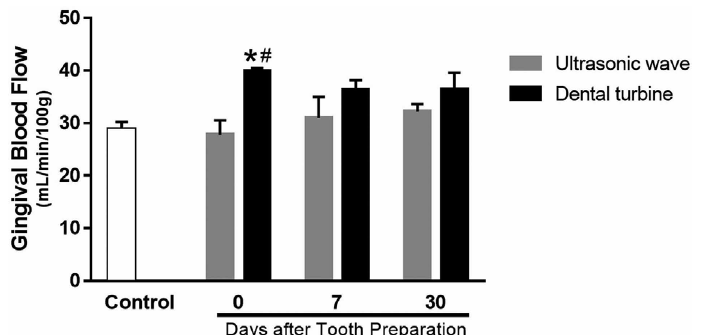
Figure 5- The effects of tooth preparation using ultrasonic or turbine on blood flow. The x axis represents the days after tooth preparation (ultrasonic: shaded column, turbine: closed column) and the y axis the gingival blood flow. Gingival blood flow was simultaneously determined at two points (mesial and centre) on each of the four lower premolar teeth and at the same site as the tooth preparation. These parameters were determined immediately (Day 0), at 7 days, and at 30 days after tooth preparation. Data are presented as the mean±the standard error of the mean (no.=6 in each method group) *P<0.05, versus the control group. #P<0.05, versus Day 0 of the ultrasonic tooth